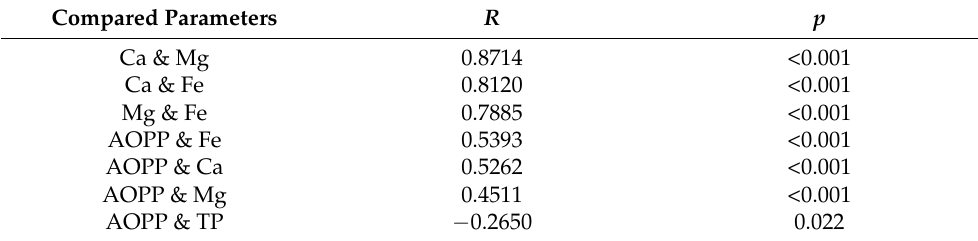
Table 2. Significant correlations between concentrations of analyzed parameters.